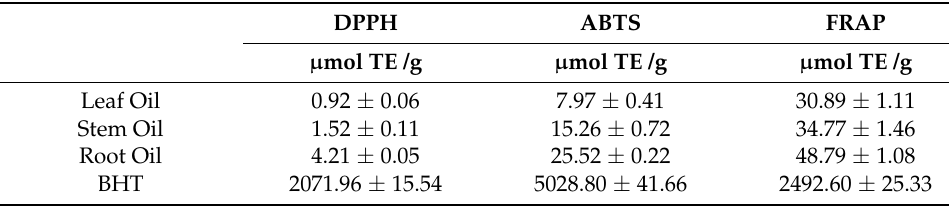
Table 2. Antioxidant activity of K. coccinea essential